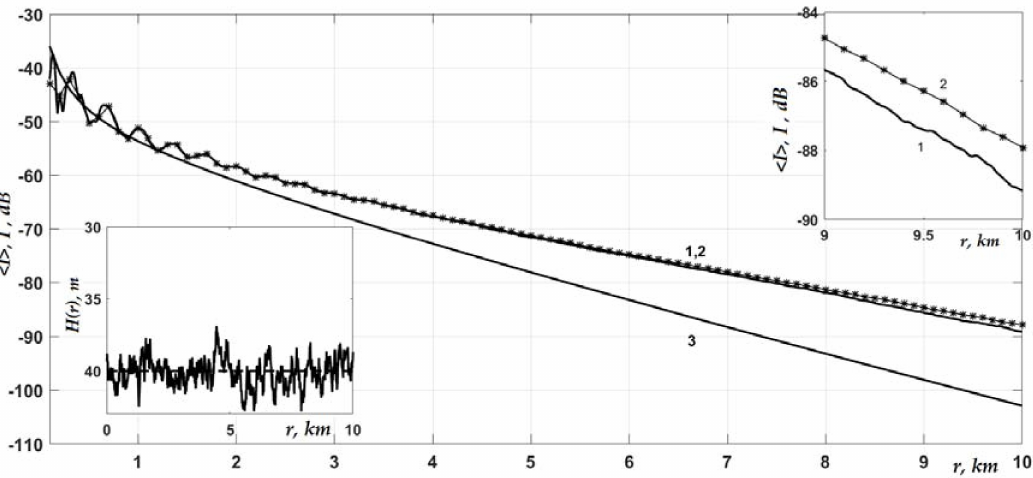
Figure 3. The average intensity is similar to Figure 2, but roughness of the bottom interface has a smaller scale, L h =100 m (see left inset on the graph).